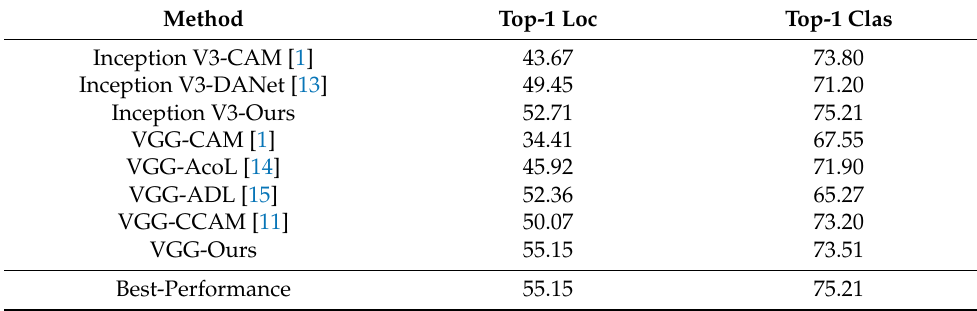
Table 1. Comparative experiments using other baseline algorithms.